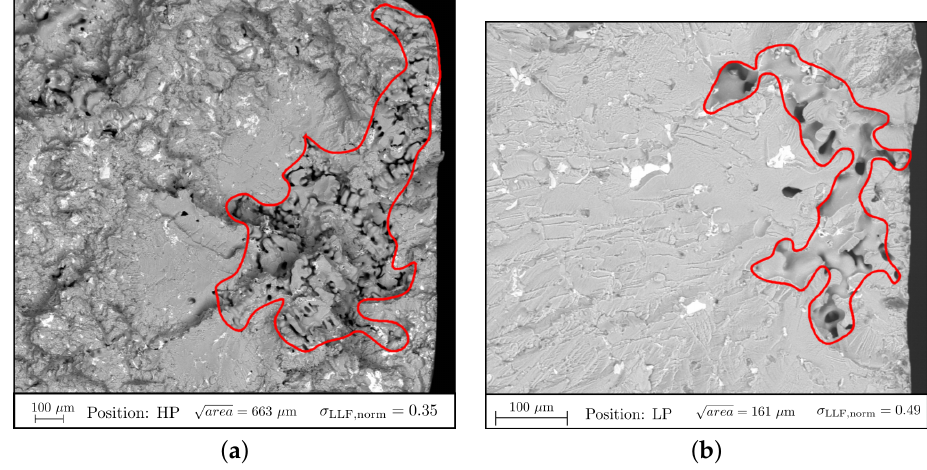
Figure 13. SEM fracture surface analysis in the HP and LP specimens. ( a ) Fracture initiating defect in the HP specimen. ( b ) Fracture initiating defect at specimen